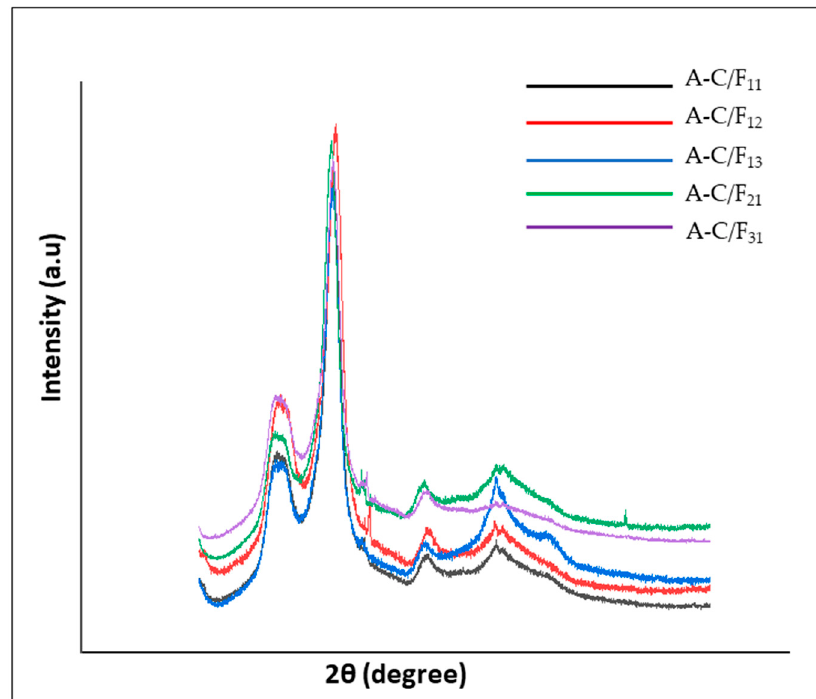
Figure 6. XRD curves of the obtained aerogel.